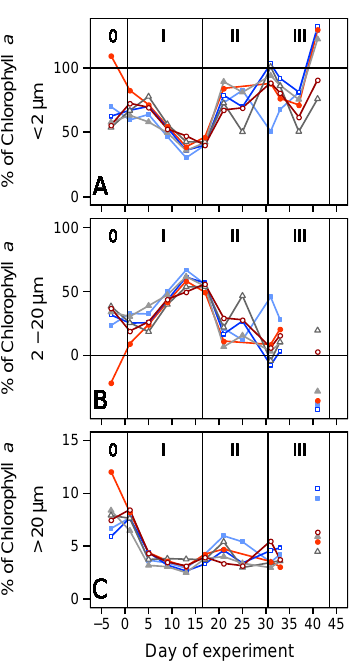
Figure 15. Relative contribution of different size fractions to to- tal chlorophyll a . Size fraction 2–20µm was calculated as a mass balance from total fraction and the two size fractions <2µm and >20µm. Colours and symbols for different treatments are described in Table 1. Values larger than 100% or smaller than 0% are due to errors in mass balance calculation.